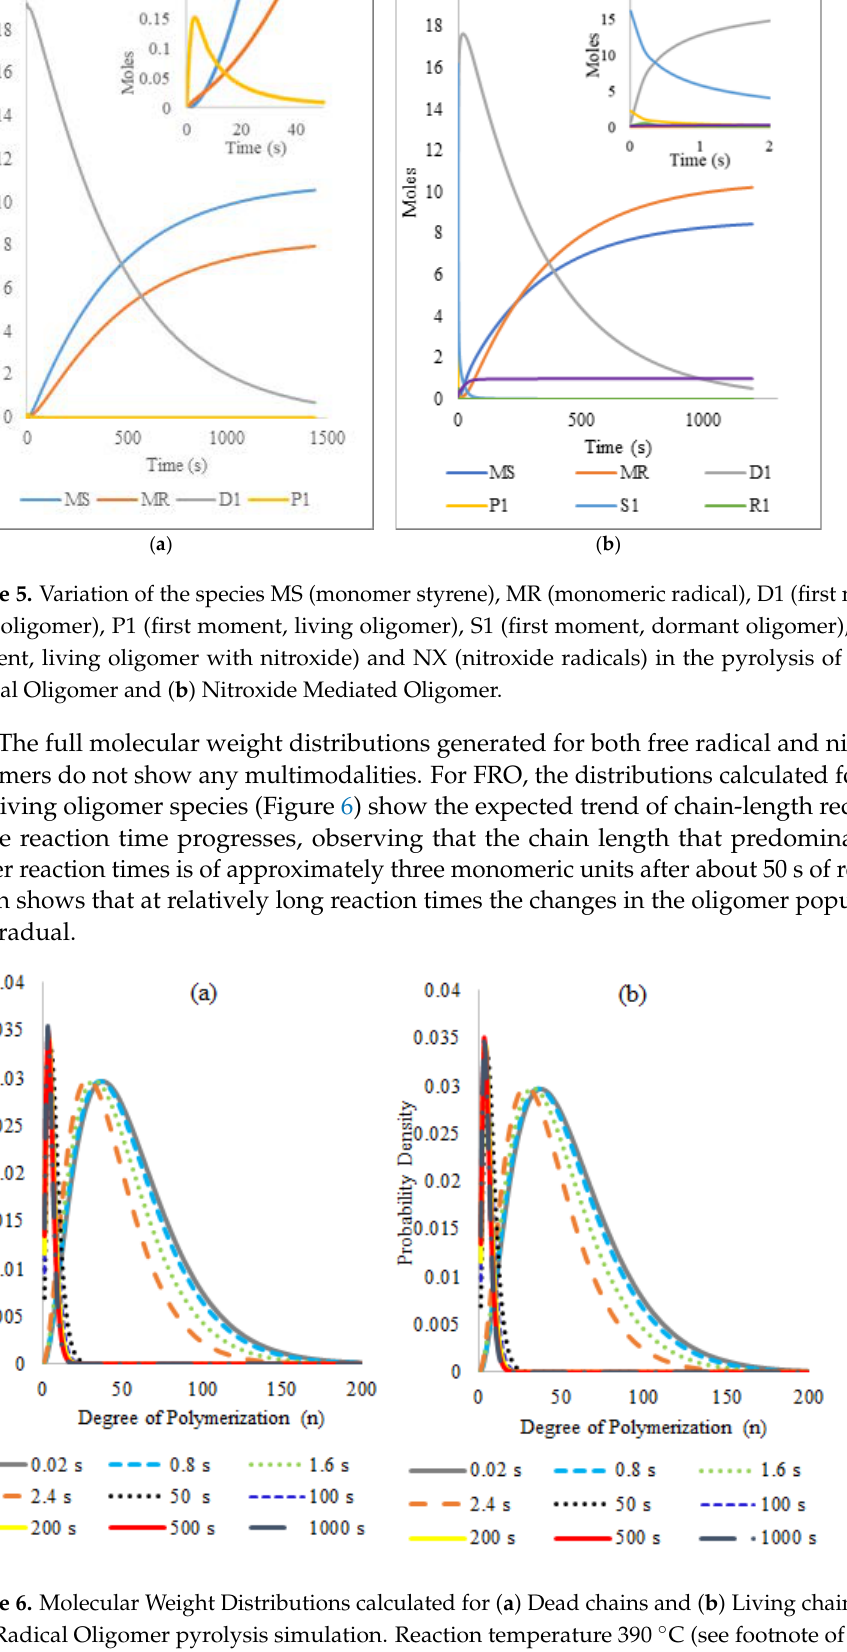
Figure 6. Molecular Weight Distributions calculated for ( a ) Dead chains and ( b ) Living chains of the Free Radical Oligomer pyrolysis simulation. Reaction temperature 390 ◦ C (see footnote of Table 5) Free Radical Oligomer pyrolysis simulation. Reaction temperature 390 °C (see footnote of Table 5) and reaction formulation as in Table and reaction formulation as in Table 2.